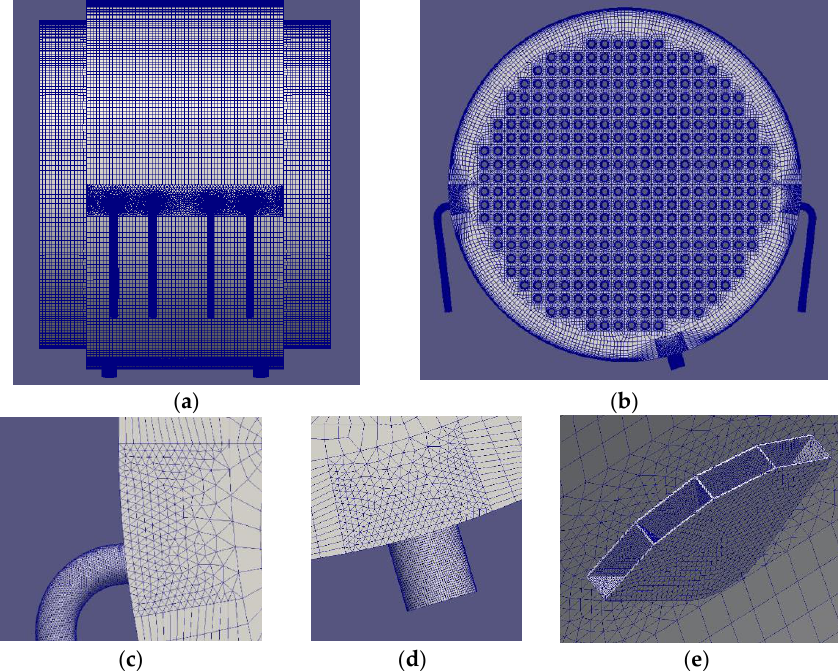
Figure 3. Grids of the prototype: ( a ) side longitudinal; ( b ) planform sectional; ( c ) inlet plumbing; ( d ) outlet exit; and ( d ) feeding Nozzle.